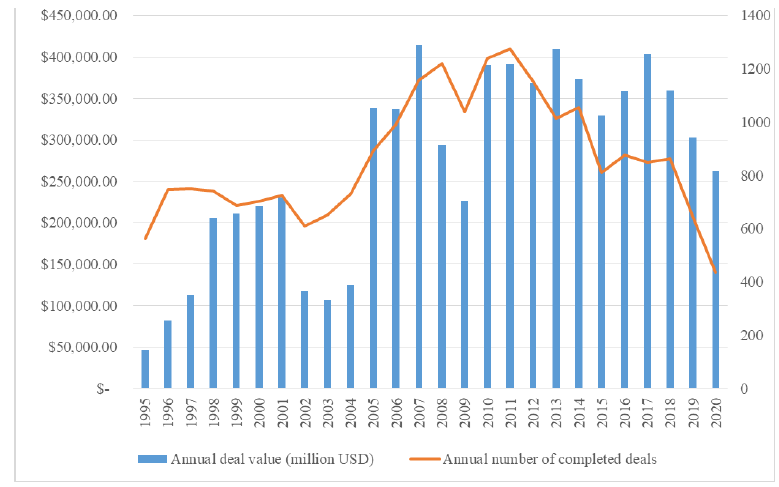
Figure 3. Annual deal value and volume of energy industry M&A market.